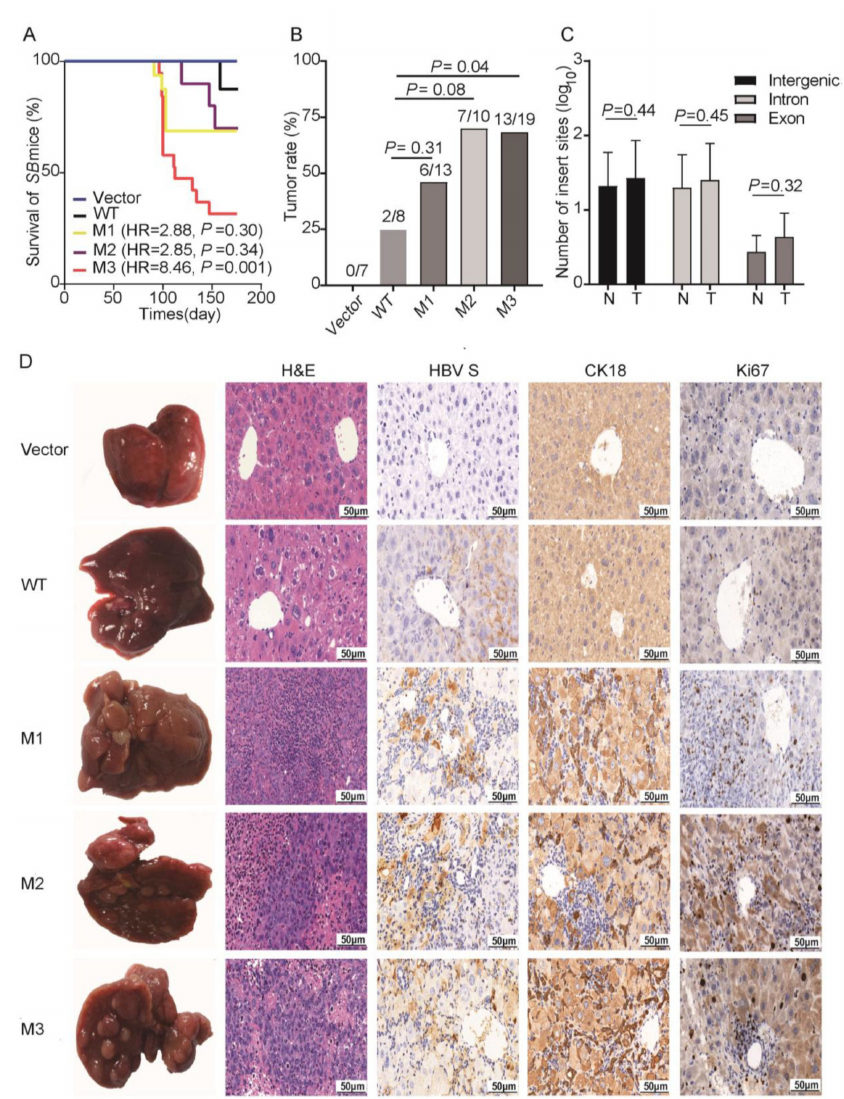
Figure 2. The survival, tumor occurrence, HBV DNA insertion sites, and pathological characteristics of the Sleeping Beauty ( SB ) mouse models. ( A ) The survival of SB mice during six-month obser- vation. Vector, WT, M1, M2, and M3 indicate the mouse models injected with the empty vector, wild-type preS1/preS2/S, G2950A/G2951A/A2962G/C2964A, C3116T/T31C, and preS2 deletion, respectively. p values were calculated by cox regression analysis. ( B ) The rate of tumor occurrence in SB mouse models, including all the survival mice and the dead mice during the observation period. p values were calculated by Student’s t -test. ( C ) The number of HBV preS1/preS2/S insertion sites in different functional regions and different tissue types. T, tumors from the mice with tumor nodules; N, liver tissues from the tumor-free mice. p values were calculated by Wilcoxon sum rank test. ( D ) Representative images of H&E and IHC staining of the livers (from Vector and WT groups) and tumors (from M1, M2, and M3 groups). Column 1, representative gross features; Column 2, representative H&E staining; Columns 3–5, representative IHC staining for HBV S protein, CK-18, and Ki67, respectively. p values were calculated by Student’s t